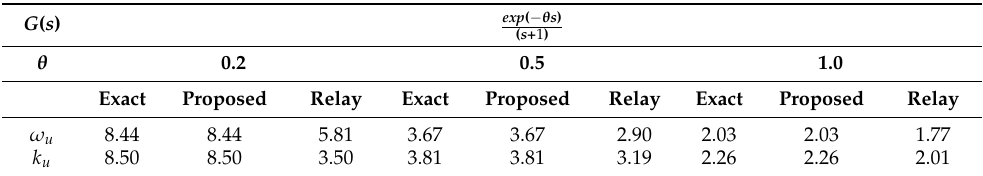
Table 1. Comparison of the proposed method and the relay feedback method [1] for the first-order plus time-delay process and PA set = − π .